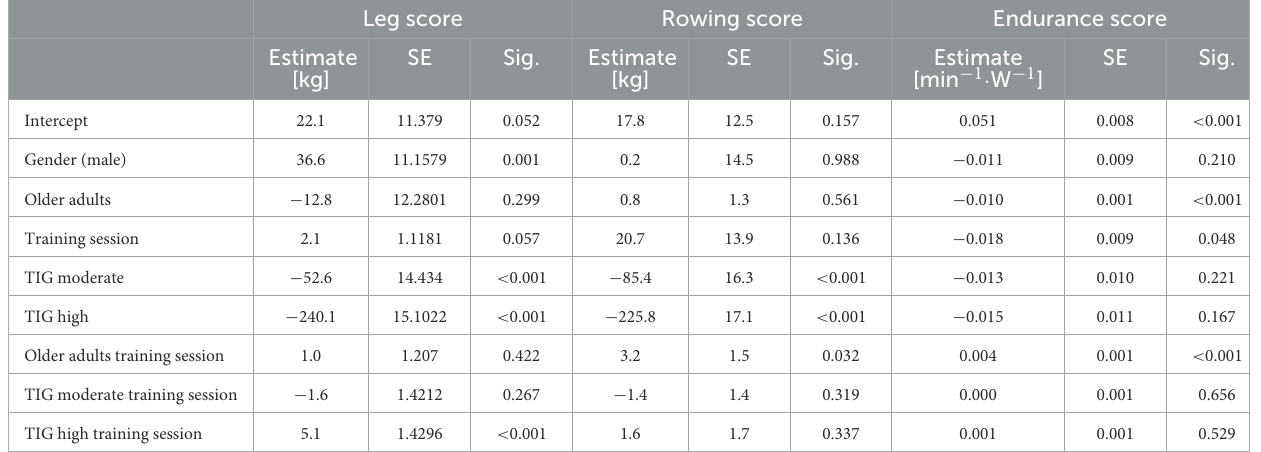
TABLE 2 Mixed regression analysis for the first 10 training session. Leg score Rowing score